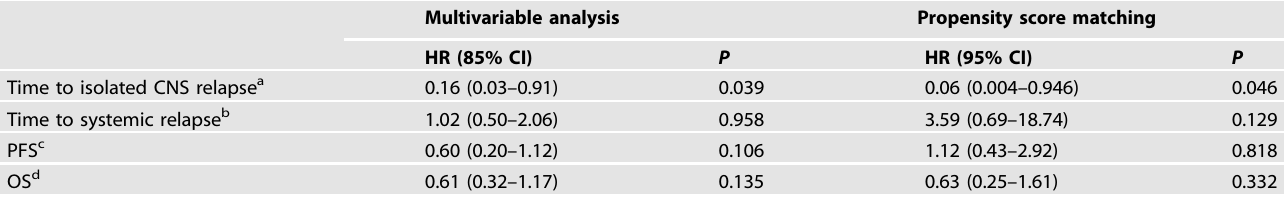
Table 3. Multivariable analysis and propensity score matching based on HDMTX prophylaxis for time to isolated CNS relapse, systemic relapse, PFS, and OS.